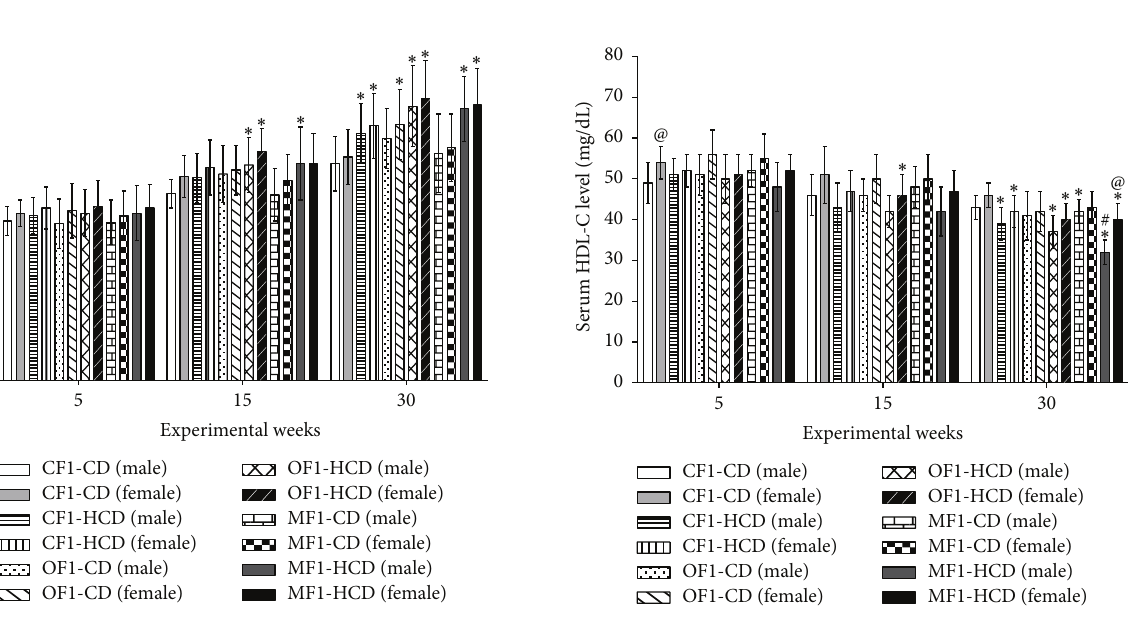
Figure 6: Serum levels of high-density lipoprotein-cholesterol (HDL-C) (mg/dL) of all study groups. Data are presented as mean ± SD ( 𝑛 = 10 ). CF1-CD: F1 offspring of control mothers under control diet, CF1-HCD: F1 offspring of control mothers under high-caloric diet, OF1-CD: F1 offspring of obese mothers under control diet, and OF1-HCD: F1 offspring of obese mothers under high-caloric diet; MF1-CD: F1 offspring of malnourished mothers under control diet and MF1-HCD: F1 offspring of malnourished mothers under high-caloric diet. The symbol ∗ indicates significant difference from CF1-CD by ANOVA ( 𝑝 < 0.05 ), the symbol # indicates significant difference from CF-HCD by ANOVA ( 𝑝 < 0.05 ), and the symbol @ indicates significant difference from male at each age by 𝑡